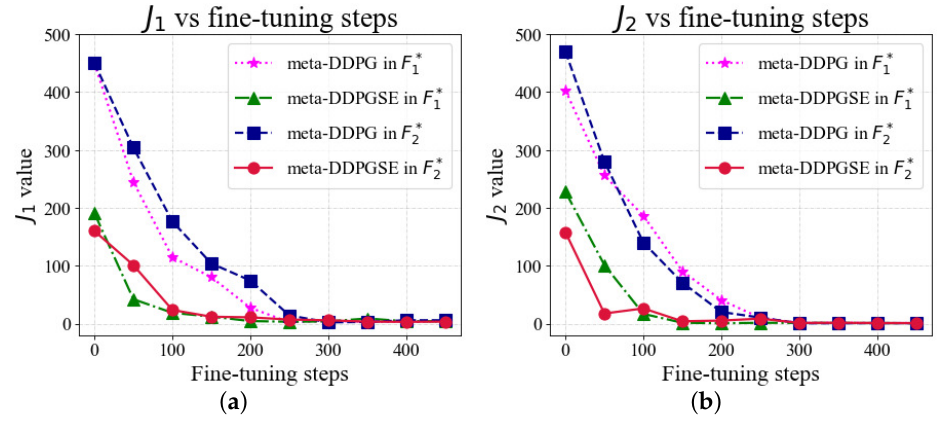
Figure 14. Effect of fine-tuning steps on J 1 and J 2 in the cornering scenario: ( a ) J 1 value vs. fine-tuning steps; ( b ) J 2 value vs. fine-tuning